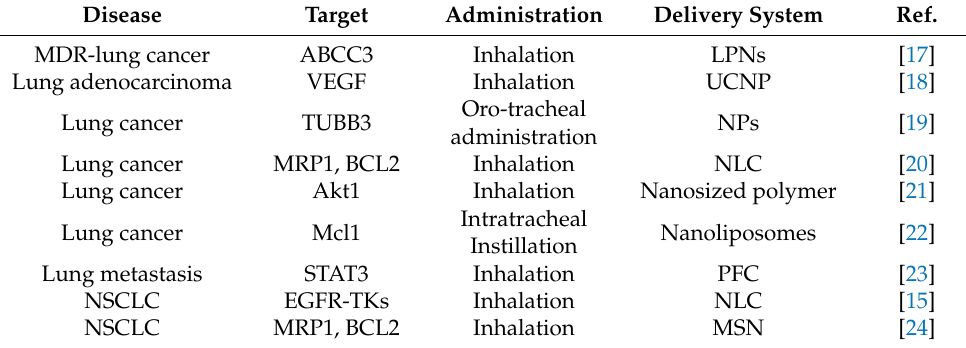
Table 1. Research of inhaled siRNA formulations for pulmonary cancer. Disease